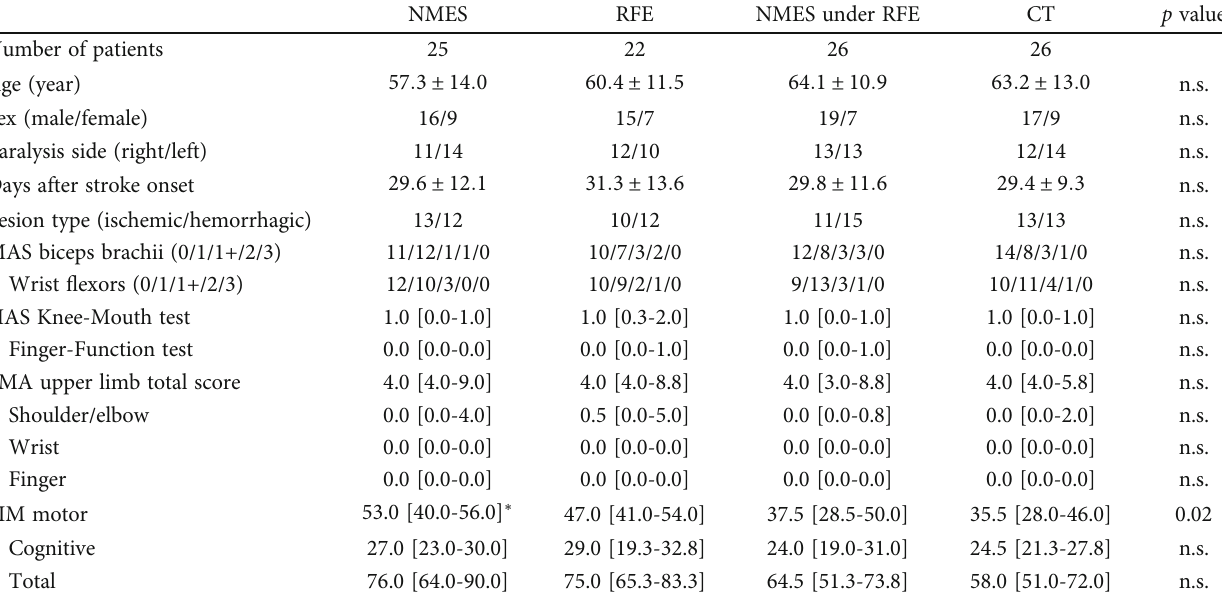
Figure 1: Flow diagram of this study. NMES: neuromuscular electrical stimulation; RFE: repetitive facilitative exercise; CT: conventional training. Table 1: Baseline characteristics of